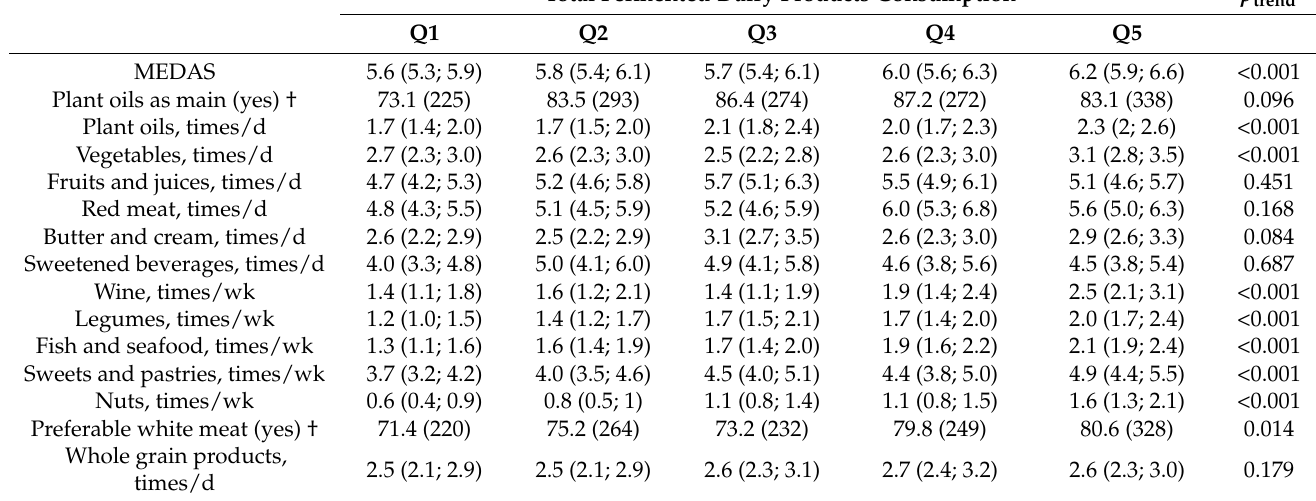
Table 2. Association between MEDAS, its components and total fermented dairy products consump- tion. Total Fermented Dairy Products Consumption